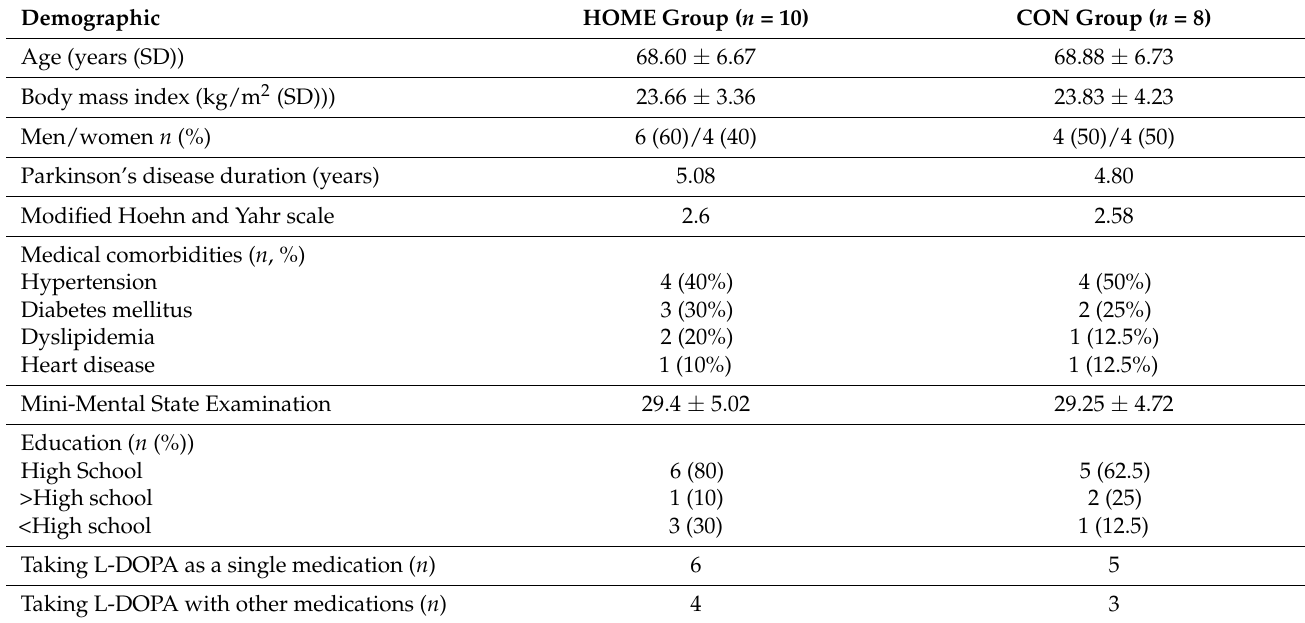
Abbreviation: HOME indicates the home-based exercise group, and CON indicates the control